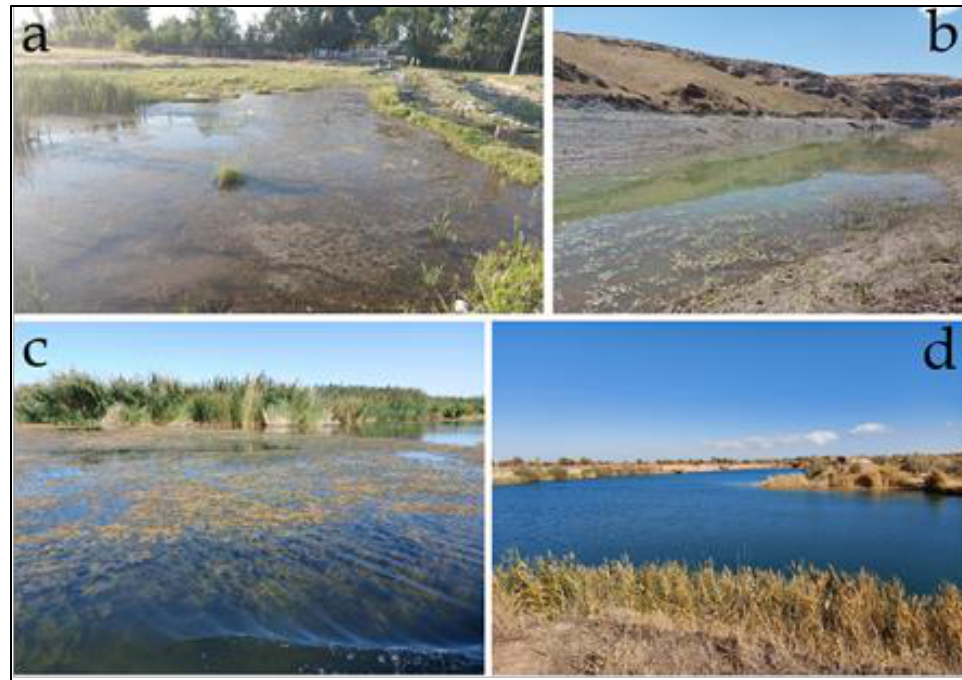
Figure 2. Sites sampled for the first time in south and southeast Kazakhstan, 2019 – 2022: The Merki River ( a ); the Copa Dam ( b ); Canal Arystan of the Ili River ( c ); Kaskelen River pond ( d ). The regional climate changes from mild warm, temperate in the west to cold, and temperate in the east. In winter, there is more rainfall than in summer. The average annual temperature decreases from west to east from 13.2 ◦ C to 8.6 ◦ C, and annual precipitation increases from 502.4 mm to 511.8-mm